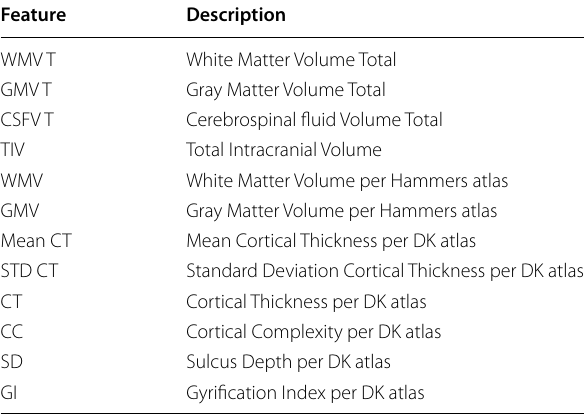
Table 2 Volume and surface features extracted from structural magnetic resonance images